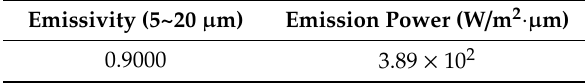
Table A1. Emissivity and emission power of the far infrared radiation by 45 ◦ C bay